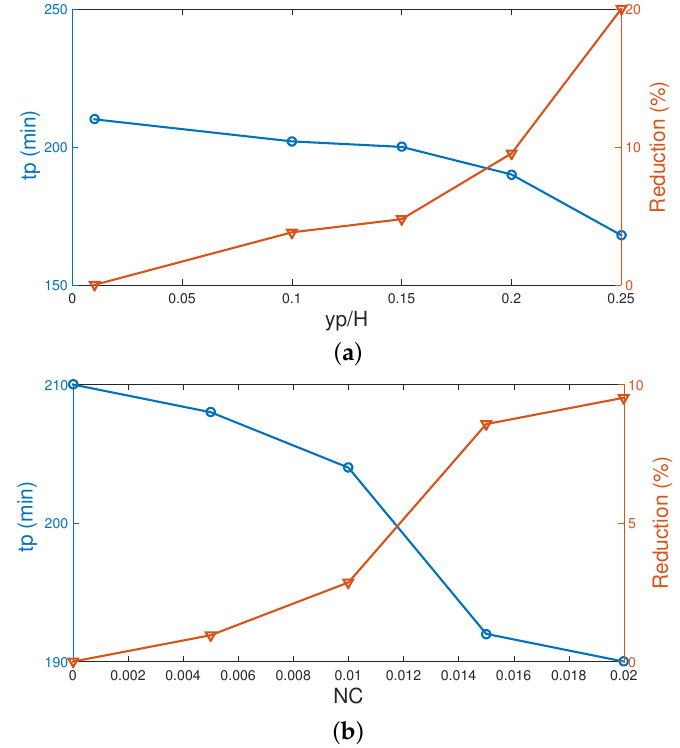
Figure 14. Impacts of PCM-zone location within the vented cavity (( a ) NC = 0.02) and including nanoparticles in the base fluid (( b ) yp = 0.1 H) on the complete phase transition time in minutes. Amount of reductions in the tp is also provided (Re = 300, Rew = 500, di = 0.25 L 1, and L 0 = 0.6 L